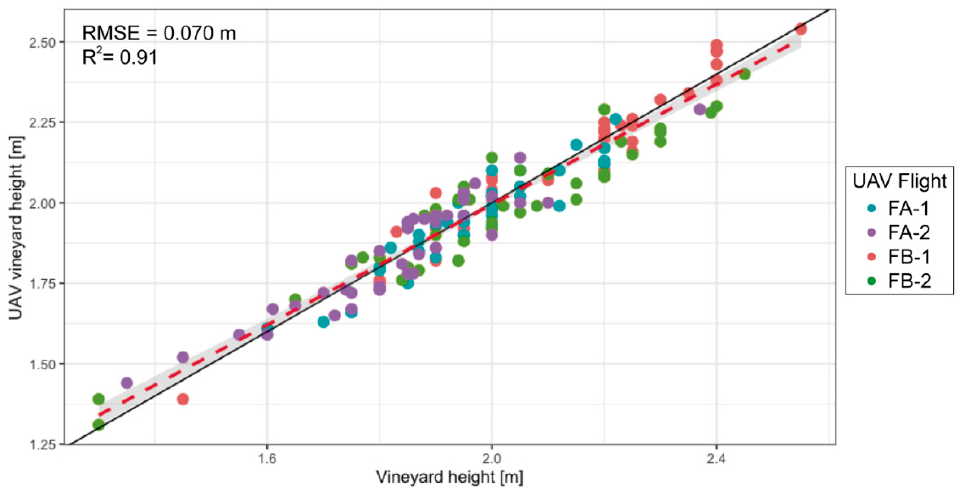
Figure 8. A graphical comparison of UAV estimated and on-ground measured vine heights for all UAV flights corresponding to Fields A and B and both dates (1: July and 2: September). The red line is the fitted linear function and the black line represents the 1:1 line. The RMSE and R 2 values ( p < 0.0001) obtained from adjustment are included.